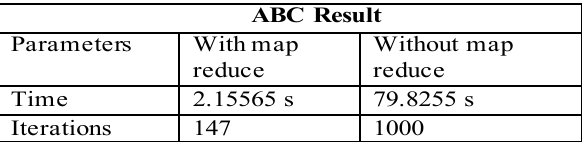
Table 2 : Results obtained using ABC